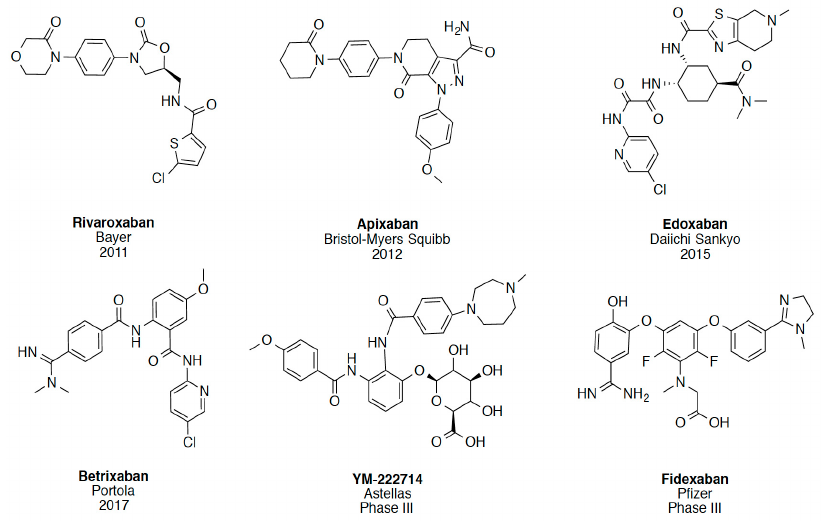
Figure 1. Currently approved and investigational FXa inhibitors.